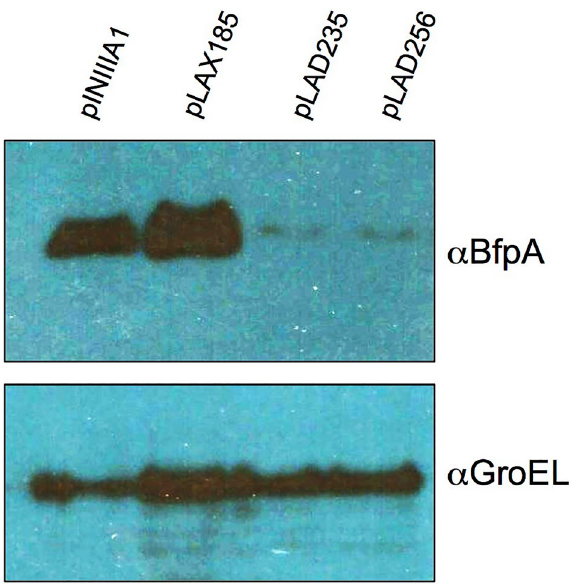
Figure 4. BfpA expression is defective in RpoA-CTD mutants. BfpA expression in EPEC WT strains transformed with pNIIIA1, pLAX185, pLAD235 and pLAD256 was detected by Western blot in strains grown in DMEM media at 37ºC in presence of 0.3 mM IPTG at D.O. 600 = 0.8. Detection of GroEL was done with anti- GroEL antibodies and used as loading and expression controls. This figure is a representative of an experiment done in triplicates.